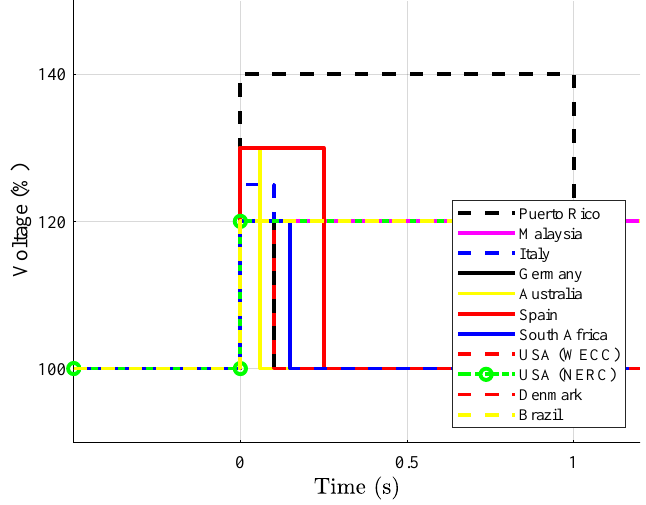
Figure 7. HVRT requirements in various